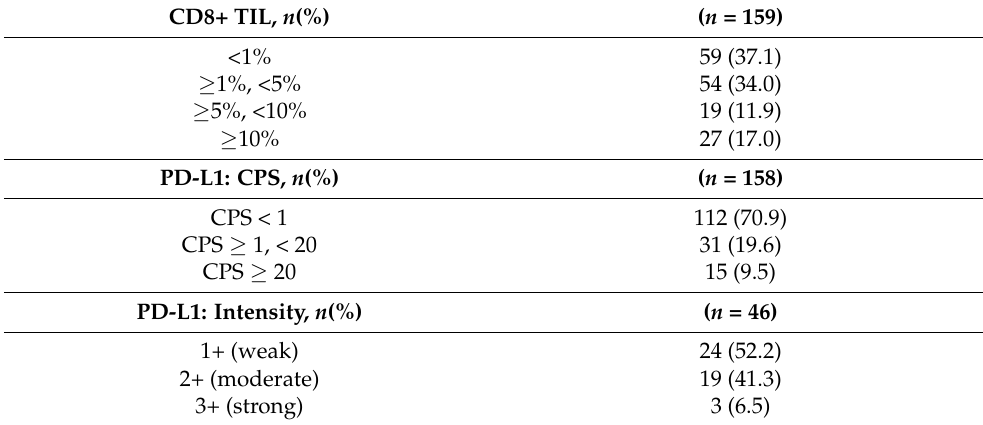
Table 1. IHC results.